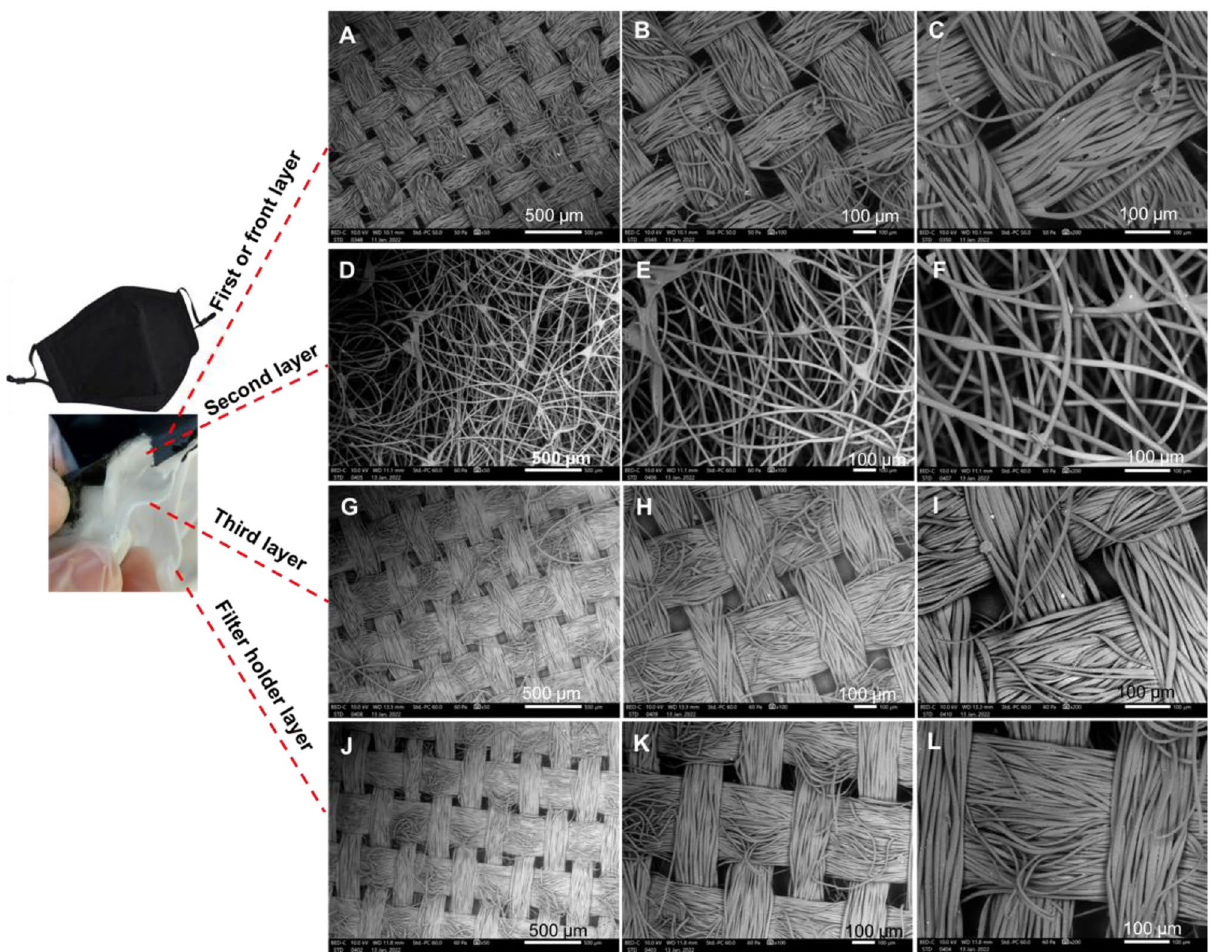
Figure 2. SEM for each of the four layers of a reusable cotton mask. ( A – C ) front layer. ( D – F ) second layer. ( G – I ) third layer. ( J – L ) Filter holder layer or back